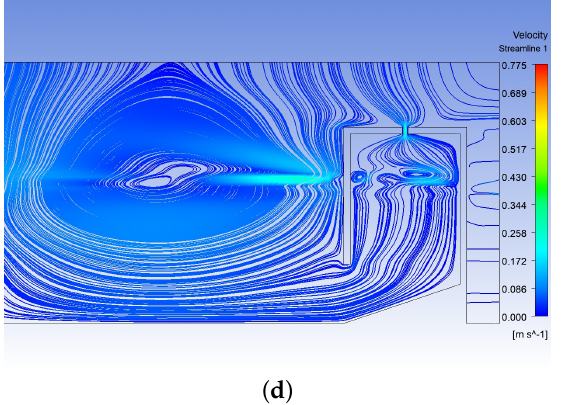
Figure 8. Streamline profile at various time instants: ( a ) t = 120 s, ( b ) t = 170 s, ( c ) t = 190 s, and